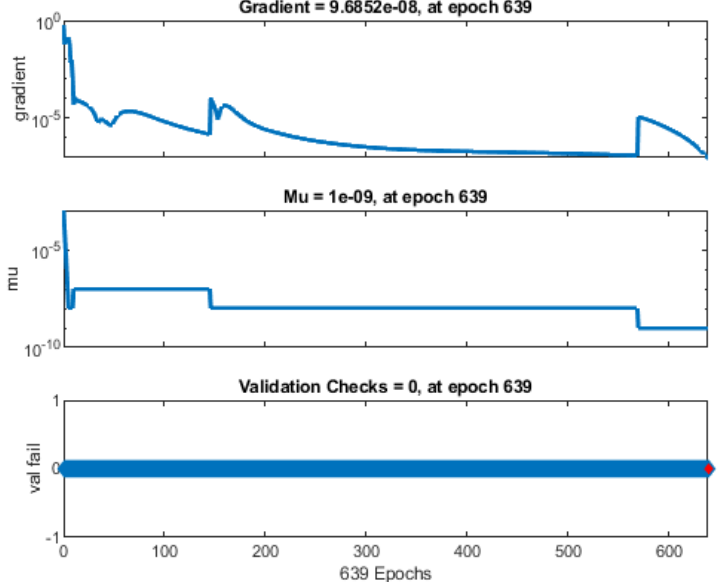
Figure 11. Illustration of the gradient function, the training gain (Mu), and the validation check.